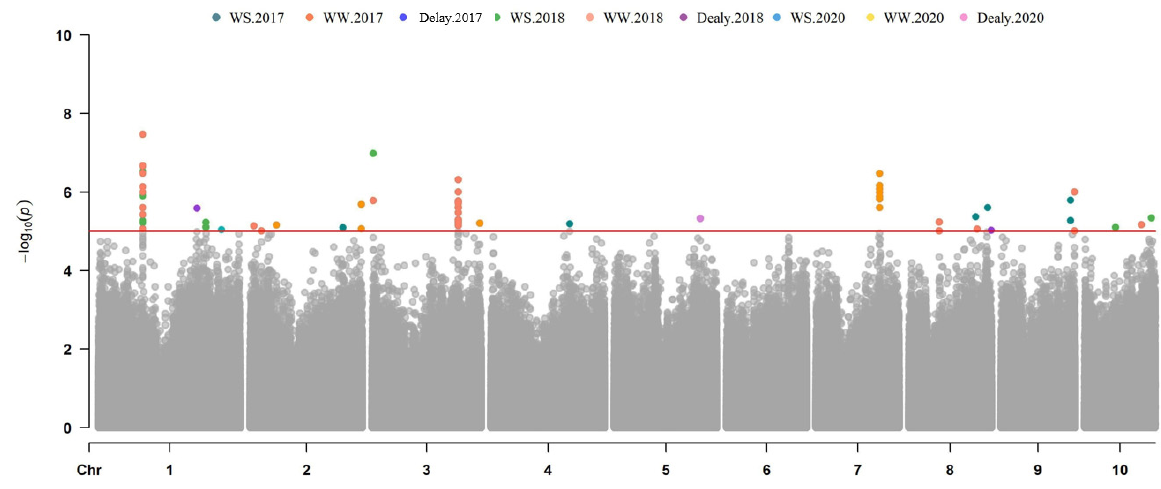
Figure 3. Manhattan plots of ASI using MLM model in three years. Table 3. Annotation of SNPs associated with ASI, EBM, and PH under multiple environments.